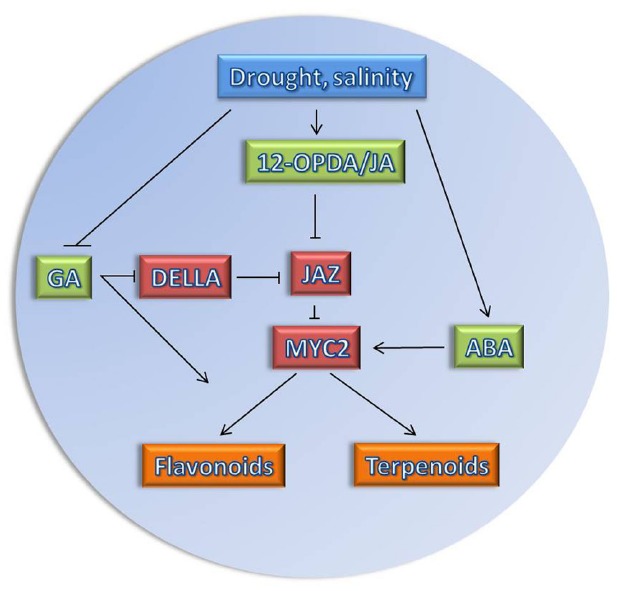
Model of JA network in response to drought/salinity stress. Osmotic stress affects the biosynthesis of the plant hormones (highlighted in green), jasmonic acid (JA), 12-oxo-phytodienoic acid (12-OPDA), and abscisic acid (ABA) positively (Takeuchi et al., 2011; Hazman et al., 2015), while the biosynthesis of GA is repressed (Colebrook et al., 2014). Changes in hormonal levels affect several important key regulatory proteins (highlighted in red). The JAZ repressor is degraded when JA is produced, such that the transcription factor MYC2 will be activated. MYC2 could work as signaling hub (Kazan and Manners, 2013) as it is also positively regulated by ABA. Due to repression of GA biosynthesis, DELLA proteins, repressors of GA signaling, will accumulate. DELLA has been shown to interact physically with JAZ proteins and hence can relieve MYC2 from JAZ repression (Hou et al., 2010). MYC2 activates secondary plant metabolic pathways such as flavonoids and terpenoids (highlighted in orange) which are required for plant adaptation to stress conditions.